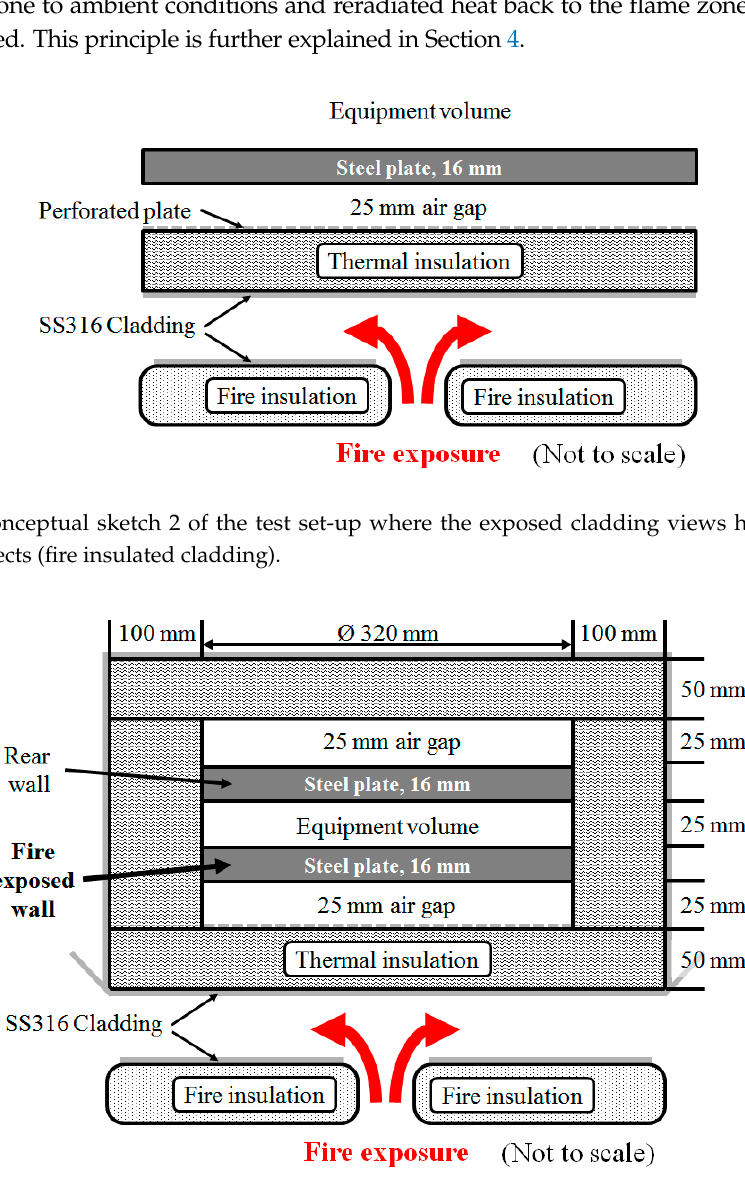
Figure 4. Conceptual sketch of the complete test set-up including mockup.